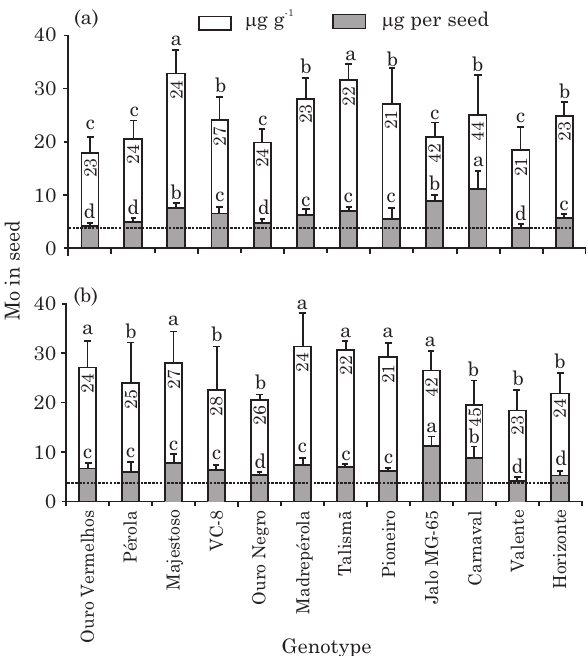
Figure 1. Effect of molybdenum (Mo) sprayed on 12 common bean genotypes at V4 (300 g ha -1 ) and R6 growth stages (300 g ha -1 ) on the Mo seed concentration ( ) and content ( ) in Oratórios in the experiments of (a) April 2008 and (b) July 2008. The filling of the white bars represents the 100-seed dry mass (in g). The seed Mo content ( µµµµµ g per seed) was calculed by multiplying the mass of one dry seed (in g) by the seed Mo concentration (in µµµµµ g g -1 ). The horizontal dotted line represents the seed Mo content (3.6 µg) at which common bean does not respond to Mo fertilization (Vieira et al., 2011b). Thin bars represent the standard